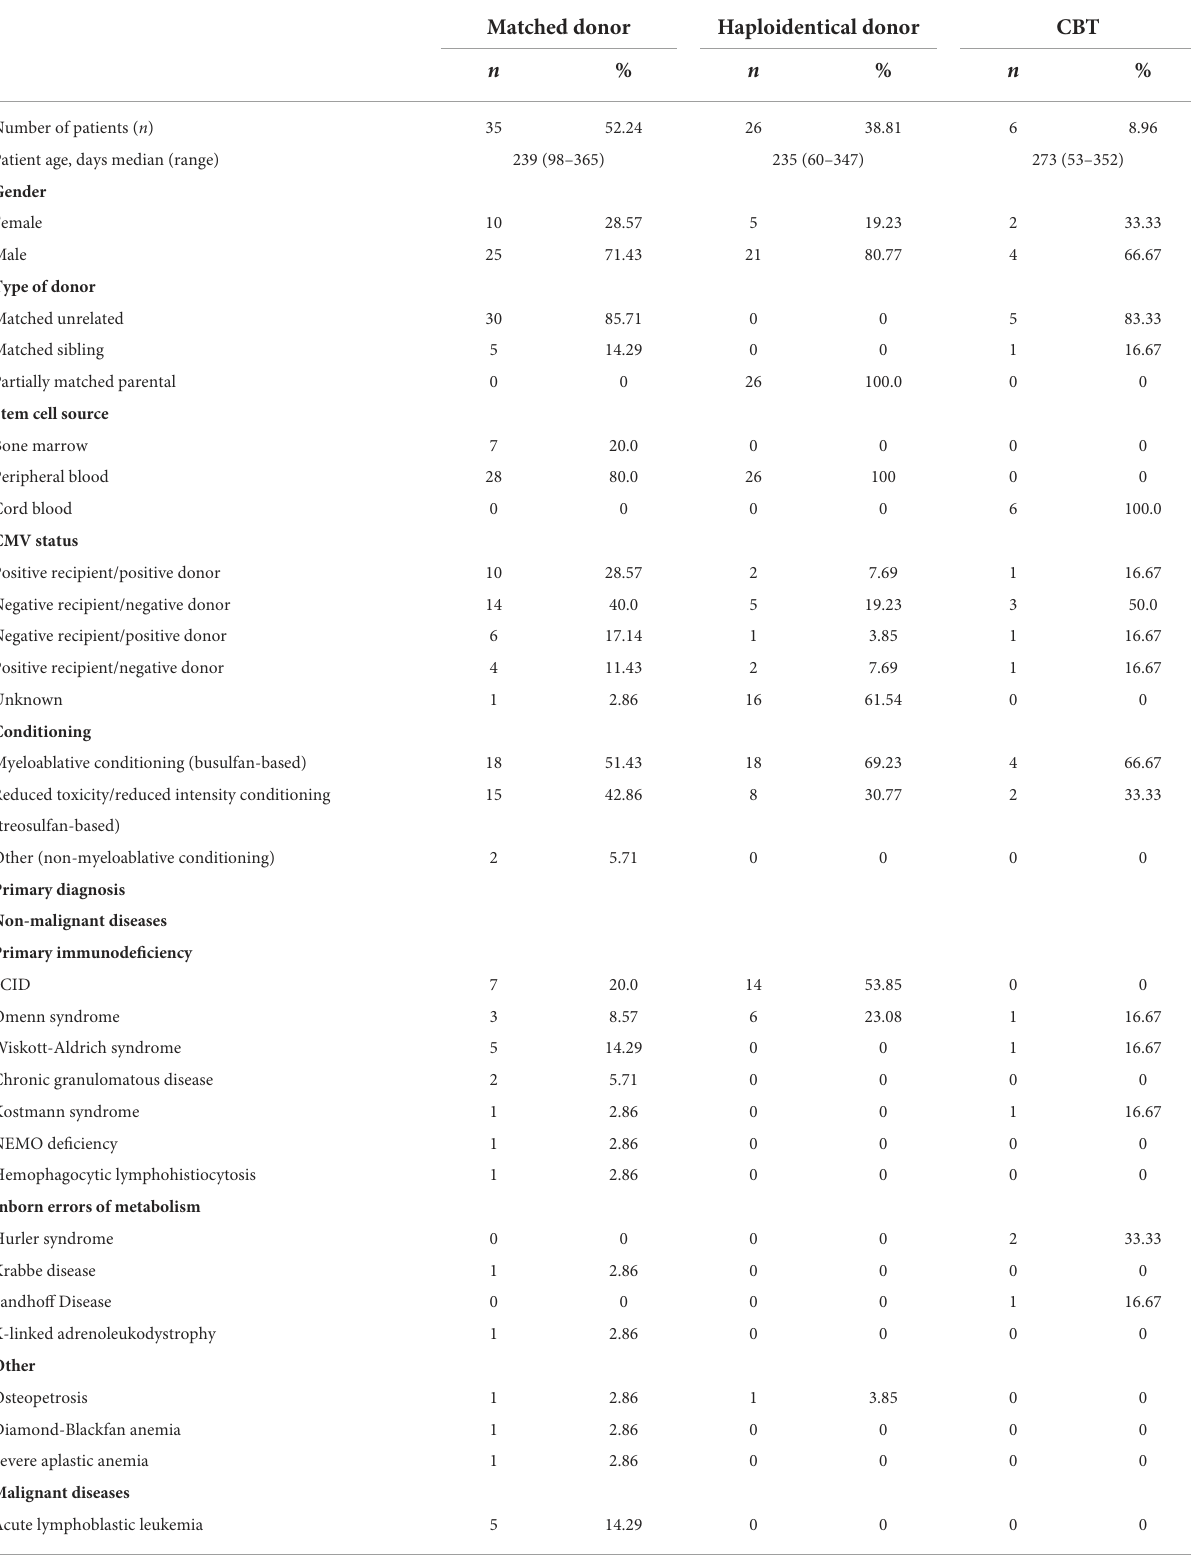
TABLE 1 Patient and transplantation characteristics.